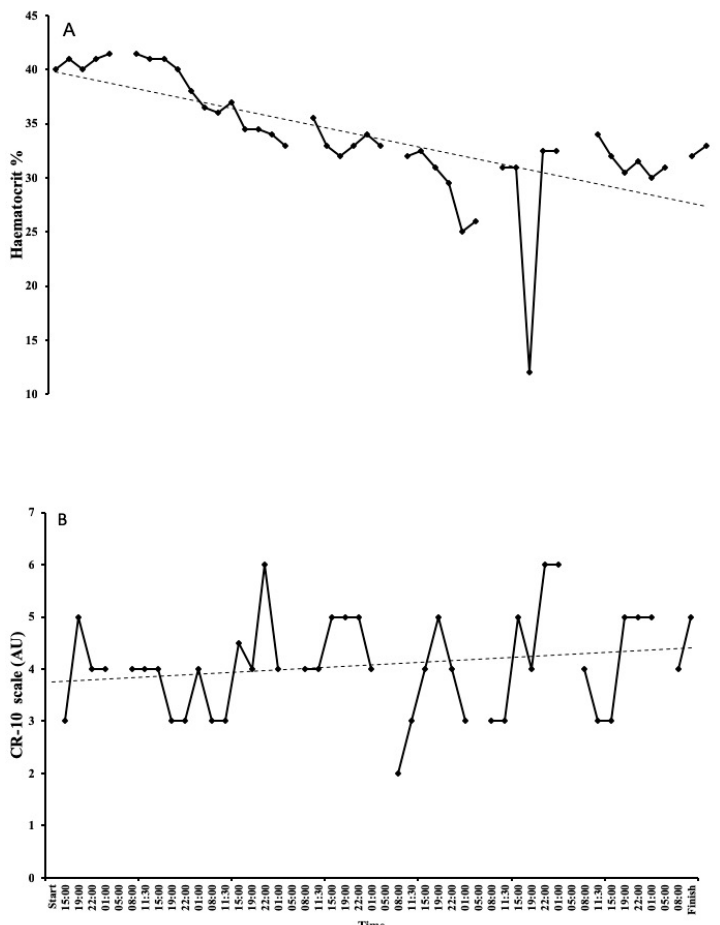
Figure 3. Changes in haematocrit ( A ) and rating of perceived exertion (RPE) ( B ) during the world record attempt. Haematocrit decreased daily. RPE remained stable and higher readings were typically seen later in the day. One very low reading coincided with a period of walking. Please note missing data are from sleep periods lasting from 1–5 a.m.